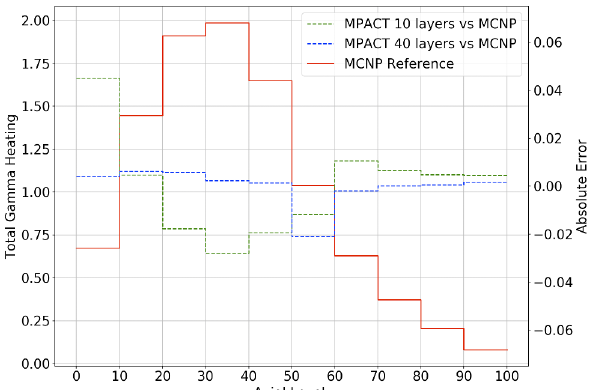
Figure 5: 5 × 5 Assembly Axial Gamma Heat Distribution MCNP Maximum Relative Uncertainty: